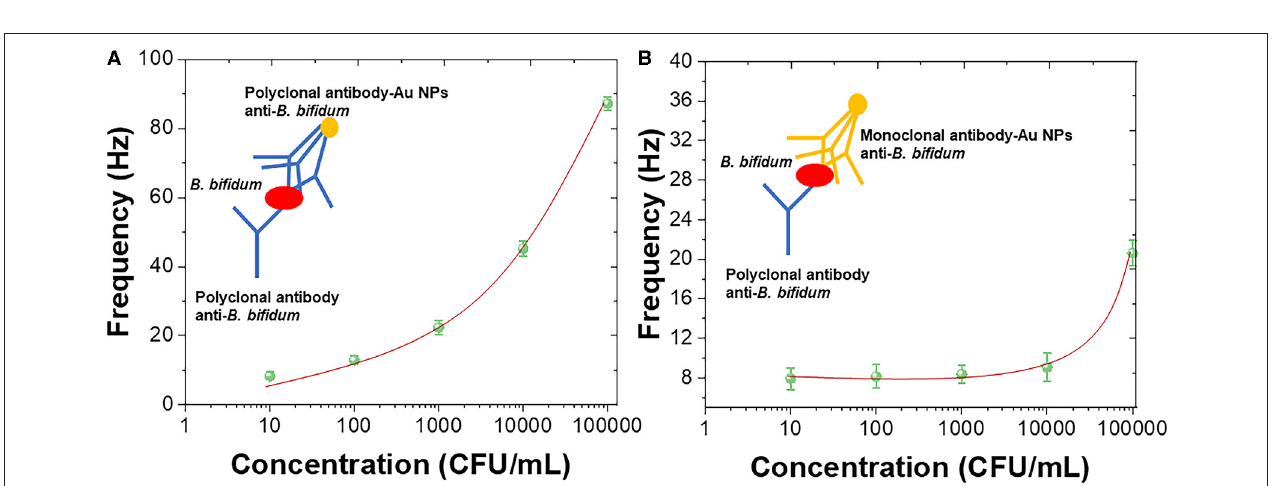
FIGURE 4 | Frequency vs. concentrations of B. bifidum using (A) polyclonal antibody and (B) mouse monoclonal antibody as the detection antibodies.